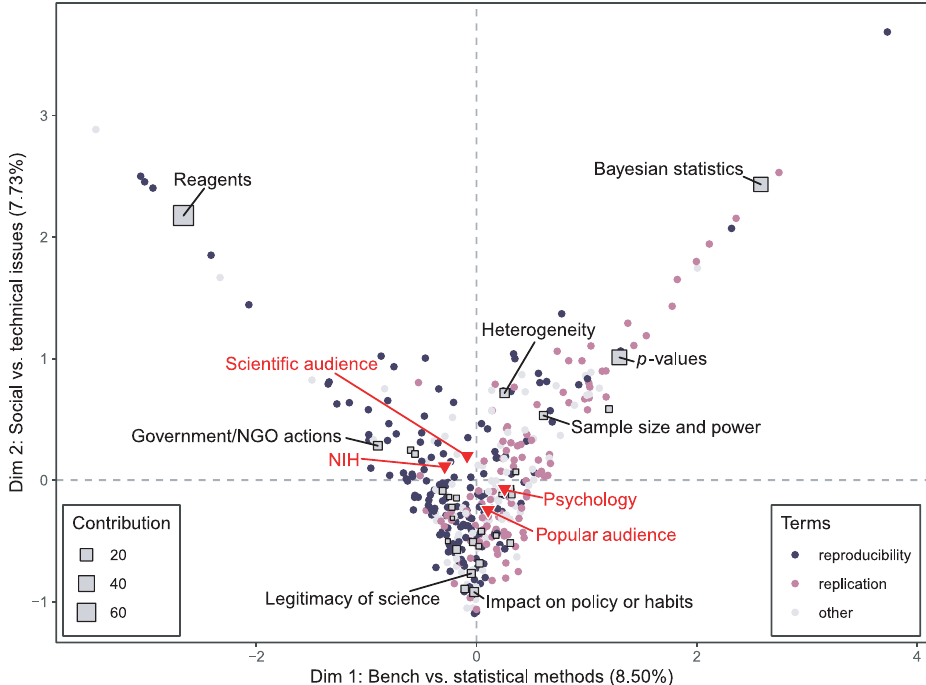
Fig 3. Correspondence analysis biplot of 353 articles discussing reproducibility, analyzed for 29 themes. Articles that are close together have similar narrative profiles. The closer an article appears to the center of the plot, the more closely it resembles the mean profile for all articles. The further away a theme is from the origin, the more variation there is in how authors discuss that theme. The color of an article’s plotted point (a circle) indicates the main term used in the article, and the size of a theme’s plotted point (a square) represents the contribution of that theme to constructing the dimensions. The eight most contributing themes are labeled. Supplementary variables (not used to construct the dimensions) are labeled in